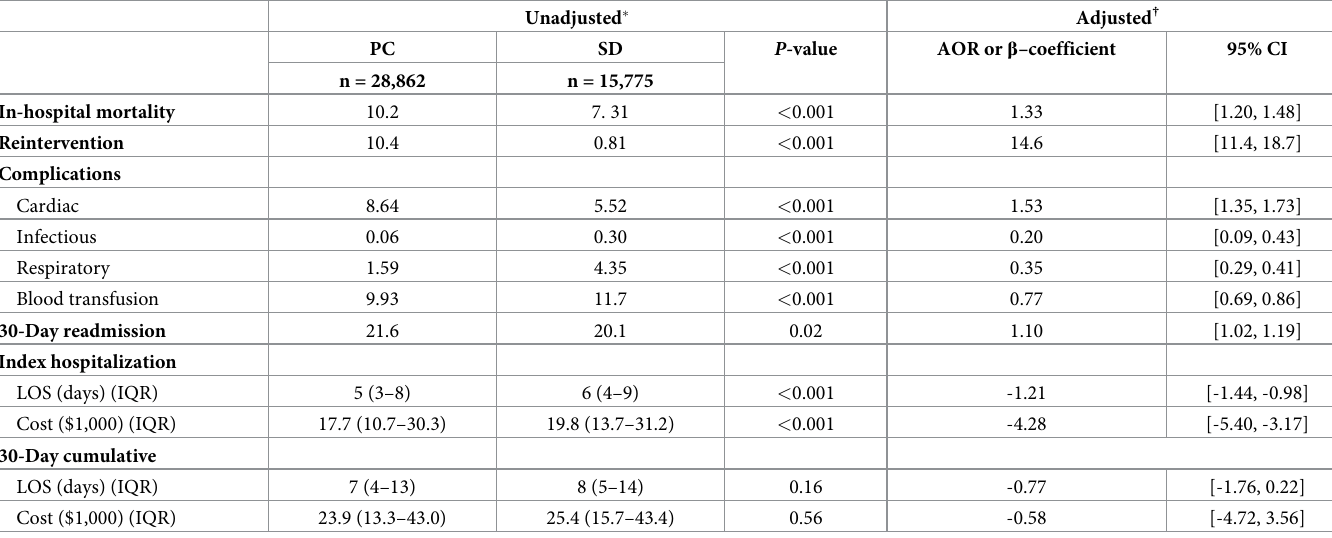
Abbreviations: PC , pericardiocentesis; SD , surgical drainage; AOR , adjusted odds ratio; 95% CI , 95% confidence interval; LOS , length of stay; IQR , interquartile range. � Unadjusted outcomes reported as percentages or median with